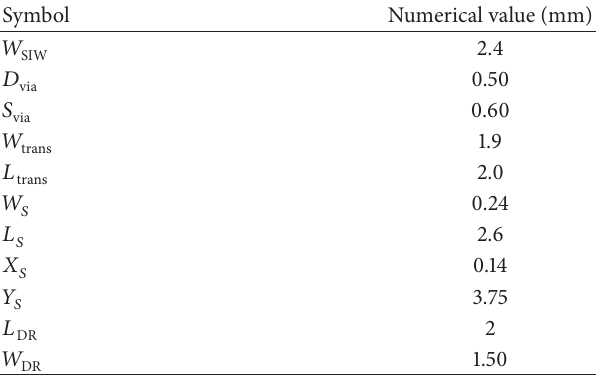
Table 1: Antenna design parameters.